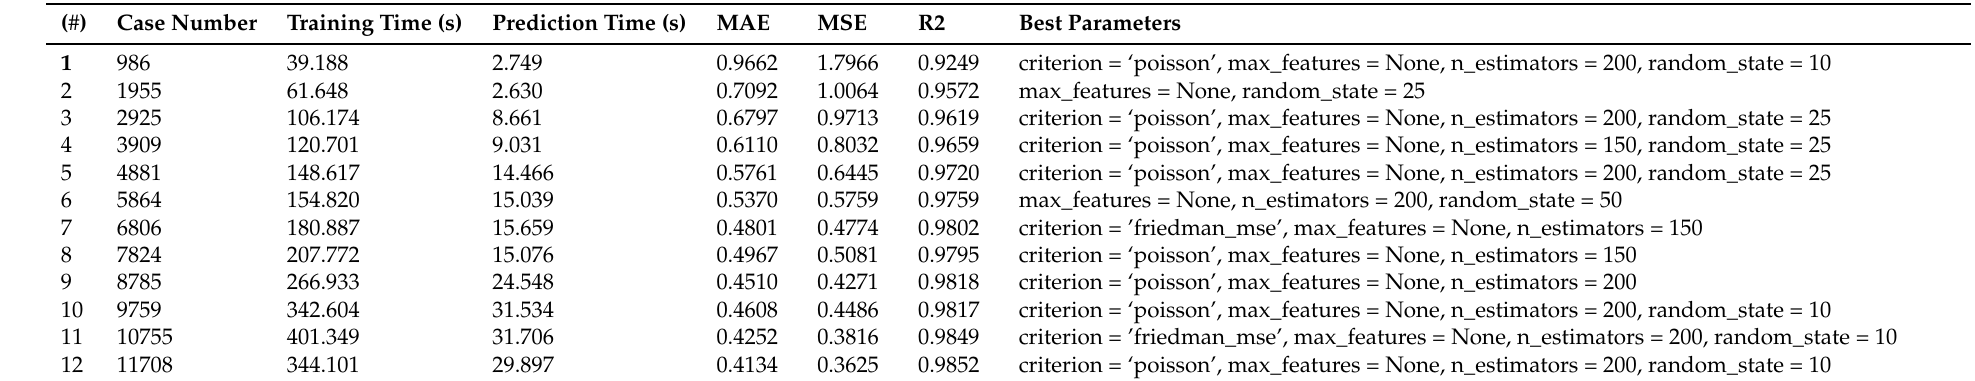
Table A2. Results of running the model with: